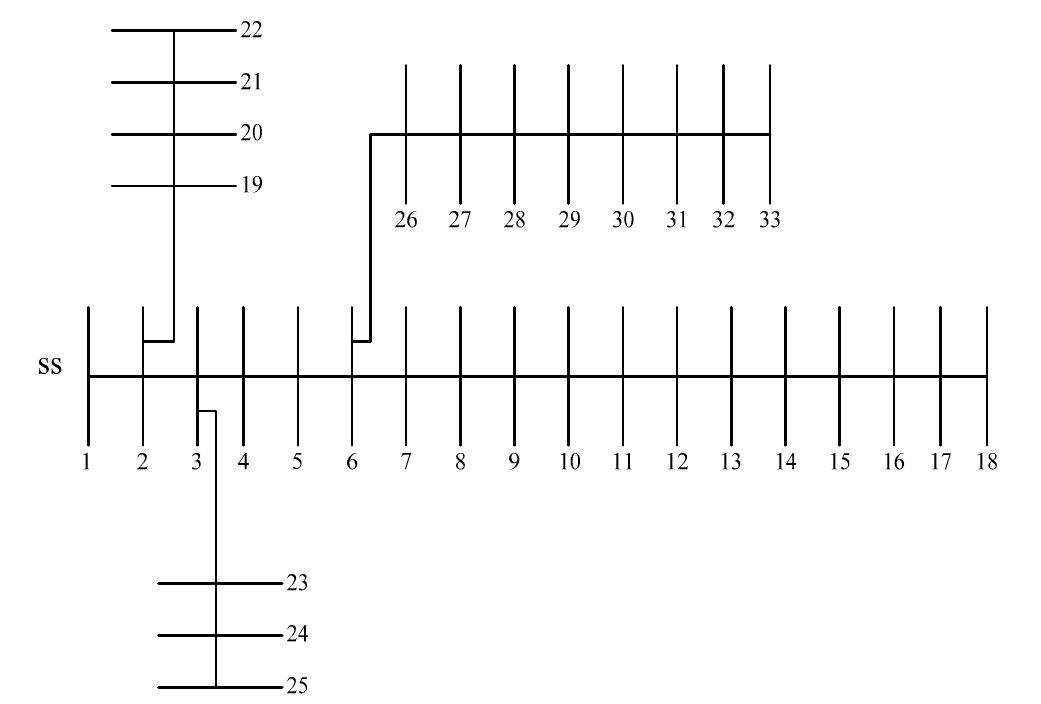
Figure 3. Sample line diagram of standard 33-bus test system.